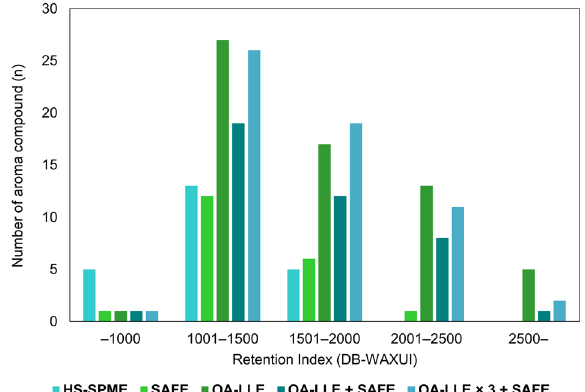
Fig. 5 The number of aroma compounds obtained from the EVOO using each method. The number of aroma compounds obtained by HS-SPME, SAFE, OA-LLE, OA-LLE + SAFE, and OA-LLE × 3 + SAFE was 23, 20, 63, 41, and 59, respectively. The amount of EVOO (cv. Hojiblanca) used for the extractions was 15.0 g for OA-LLE × 3 + SAFE and 5.0 g each for the others. The combination of OA-LLE and SAFE improved the aroma extraction ef fi ciency without non- volatiles appearing in the aromatic extracts. The aroma compounds exceeding RI 2000 were signi fi cantly